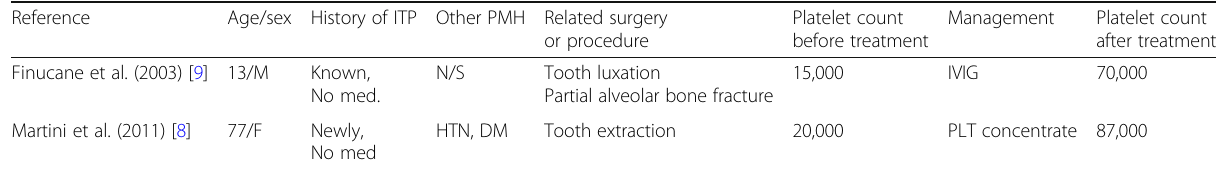
Table 2 Reported cases of oral hemorrhage after surgery or procedure in oral and maxillofacial area Reference